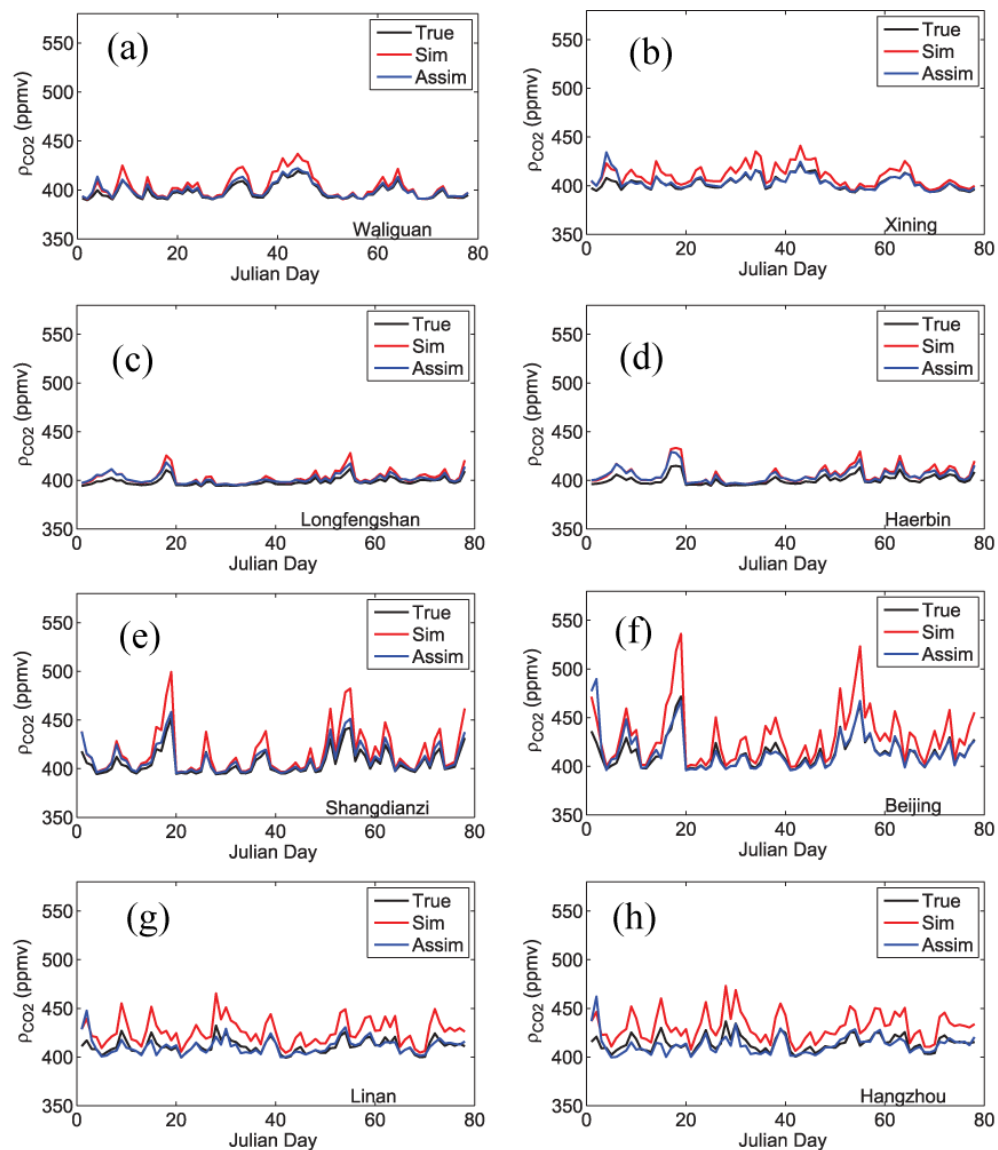
Figure 6. Daily mean time series of CO 2 concentrations at national background stations in China and their nearest large cities from 1 January to 20 March 2010 extracted from the artificial true simulations C p t (black), background simulations C f t (red), and the ensemble mean values of the assimilated CO 2 concentrations fields C a t (blue). All time series were interpolated to the observation locations by the spatial bilinear interpolator method. The sites used are (a) Waliguan (36.28 ◦ N, 100.91 ◦ E), (b) Xining (36.56 ◦ N, 101.74 ◦ E), (c) Longfengshan (44.73 ◦ N, 127.6 ◦ E), (d) Haerbin (45.75 ◦ N, 126.63 ◦ E), (e) Shangdianzi (40.65 ◦ N, 117.12 ◦ E), (f) Beijing (39.92 ◦ N, 116.46 ◦ E), (g) Linan (30.3 ◦ N, 119.73 ◦ E), and (h) Hangzhou (30.3 ◦ N, 120.2 ◦